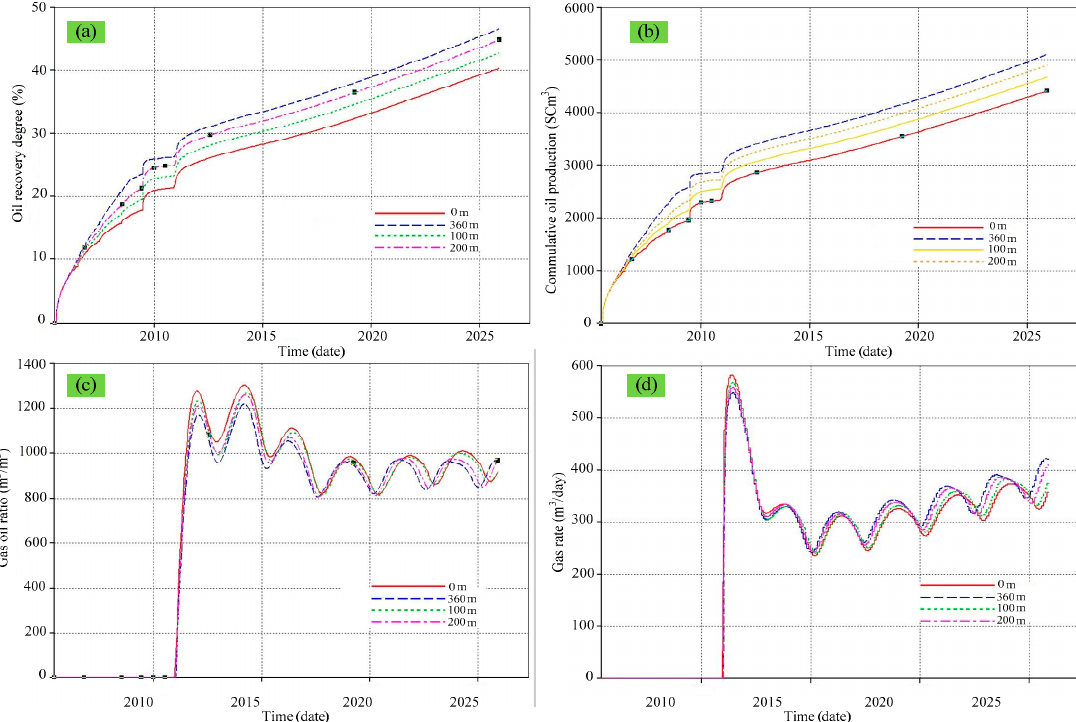
Figure 8. Comparison of the production indicators under di ff erent bottom water thickness. ( a ) recovery